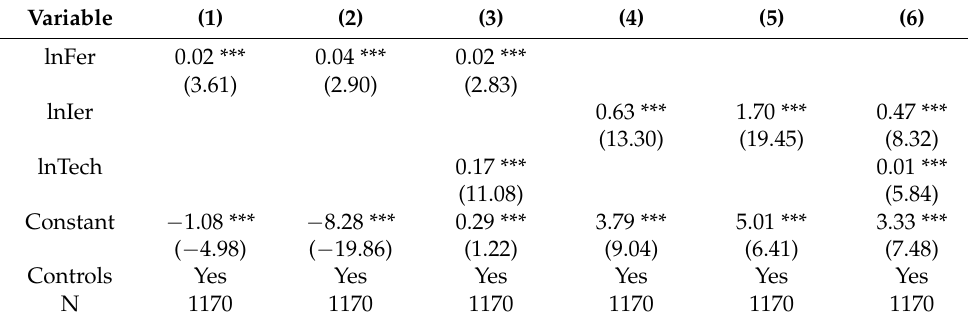
Table 4. Regression results of mediating the effect.